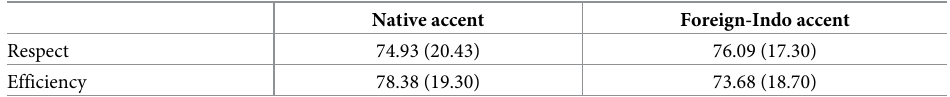
Table 2. Mean scores (SD) for Respect and Efficiency (0–100) for each Accent (native vs.